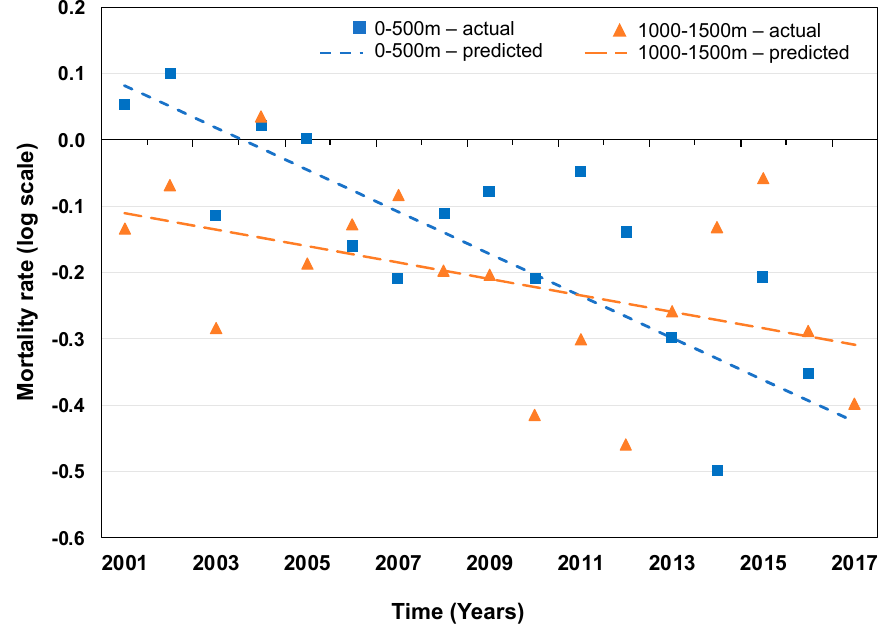
Figure 4. Mortality rates for the 0–500 and 1000–1500 m distance buffers around the canal in North Glasgow during the 2001–2017 time period of canal regeneration. The dashed lines represent the model-predicted trend in mortality rates for the 0–500 and 1000–1500 m distance buffers.